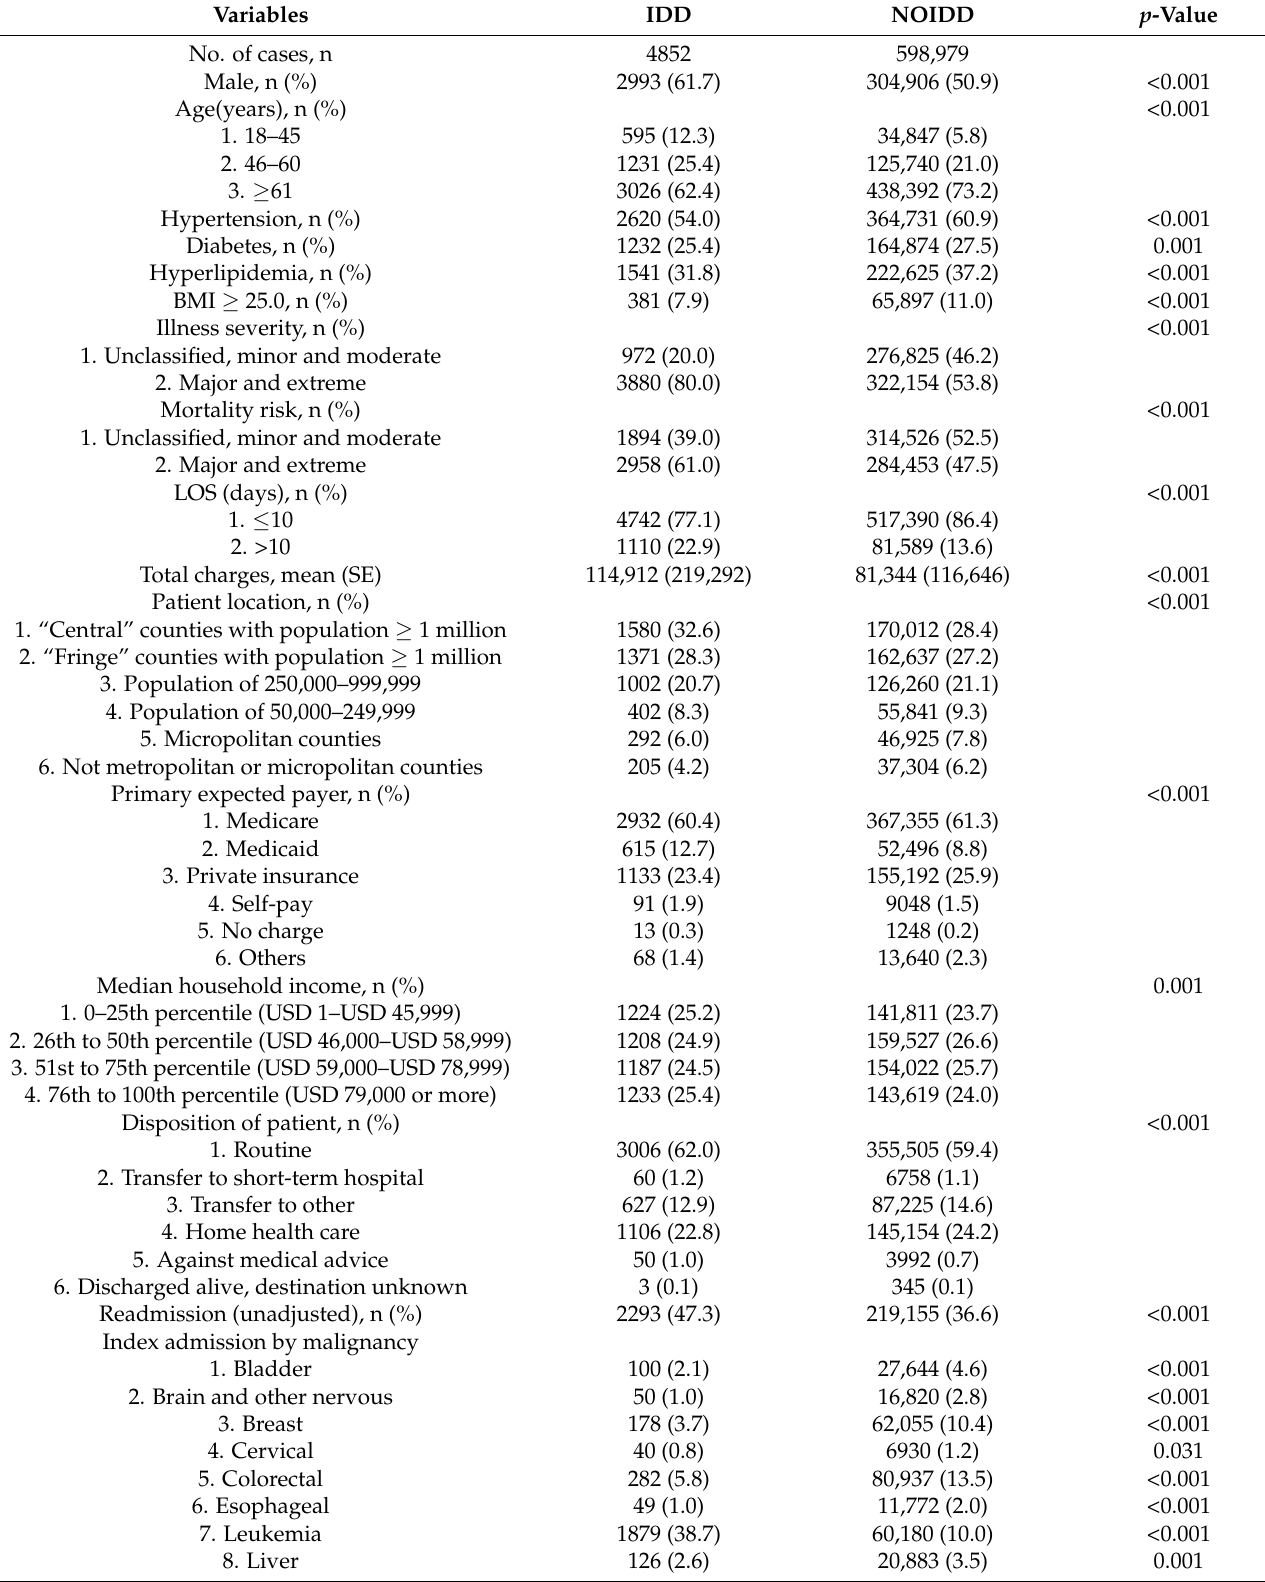
Table 1. Baseline characteristics of study population from the NRD that was classified as malignant tumor patients with or without immunodeficiency